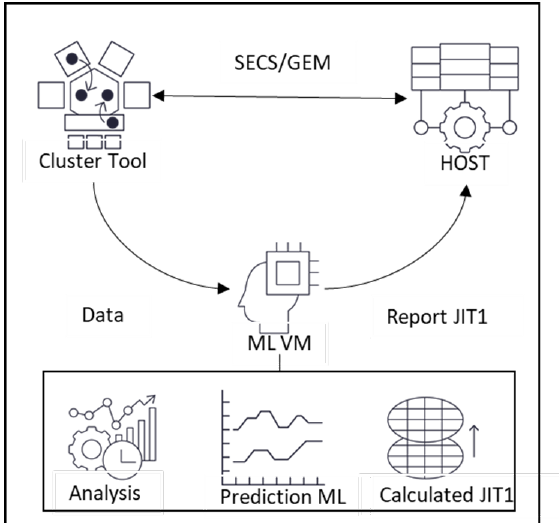
Figure 5. JIT1 optimization of semiconductor cluster tool